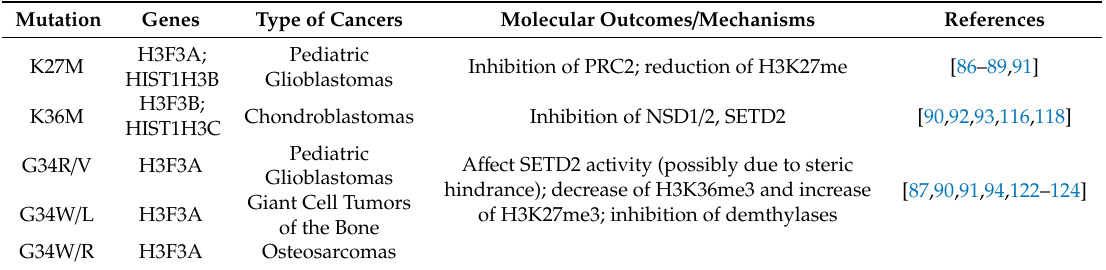
Table 1. Molecular mechanisms of histone H3 mutations in